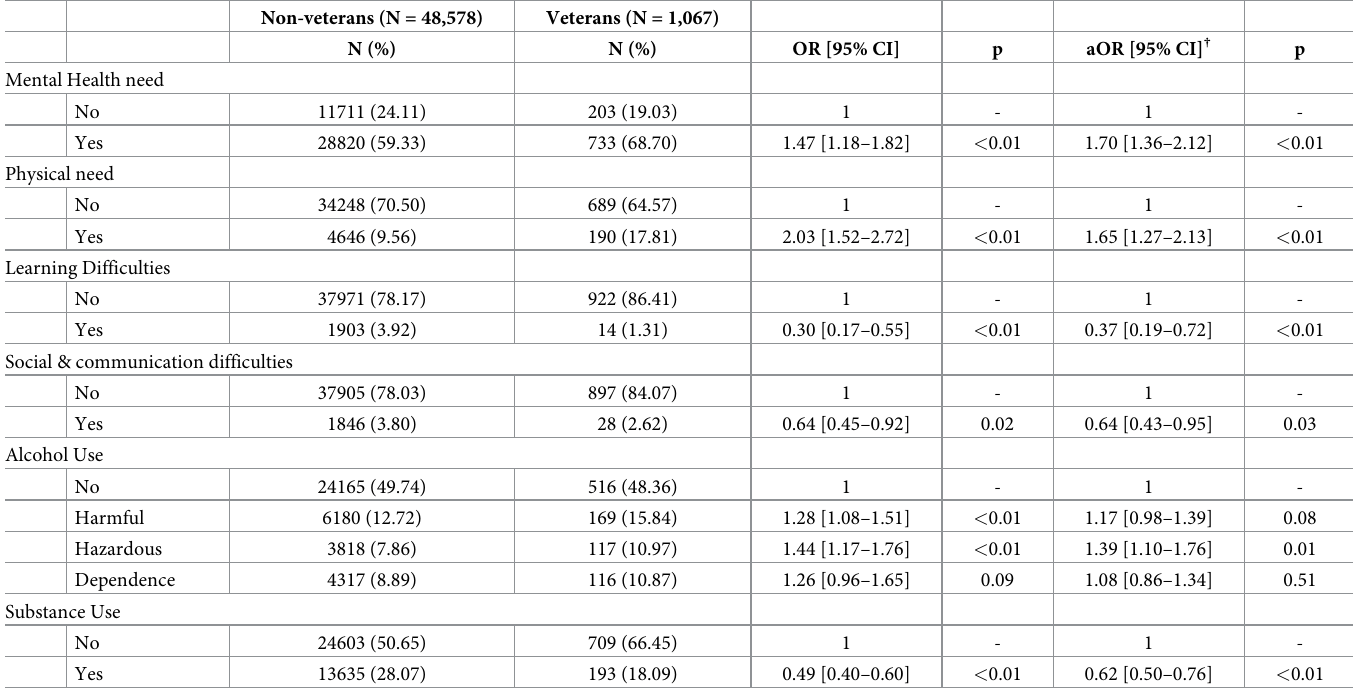
Table 3. Association of health needs with veteran